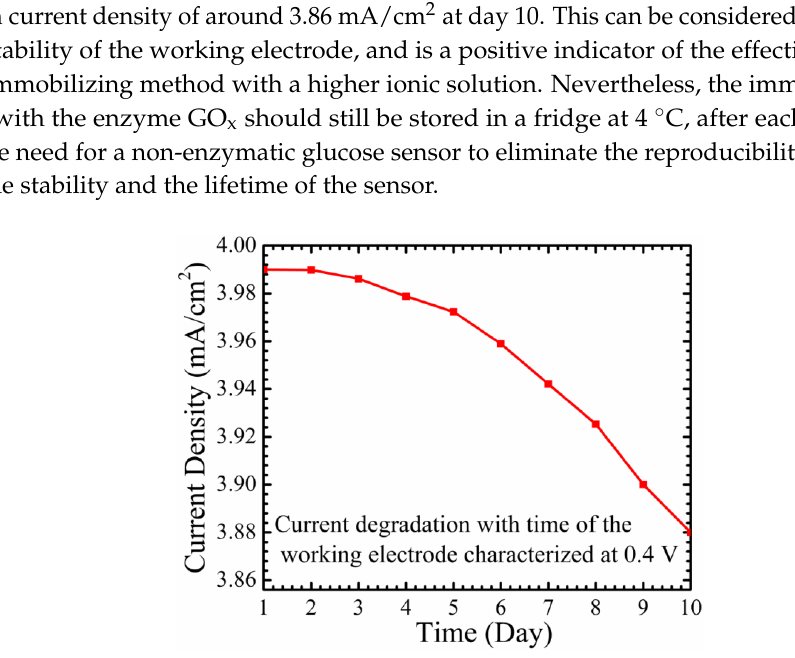
Table 1. The comparison between the current fabricated glucose sensor and other published sensors using differences in terms of sensitivity, applied oxidation-reduction potential, linear range, and the response time. Type of Electrode